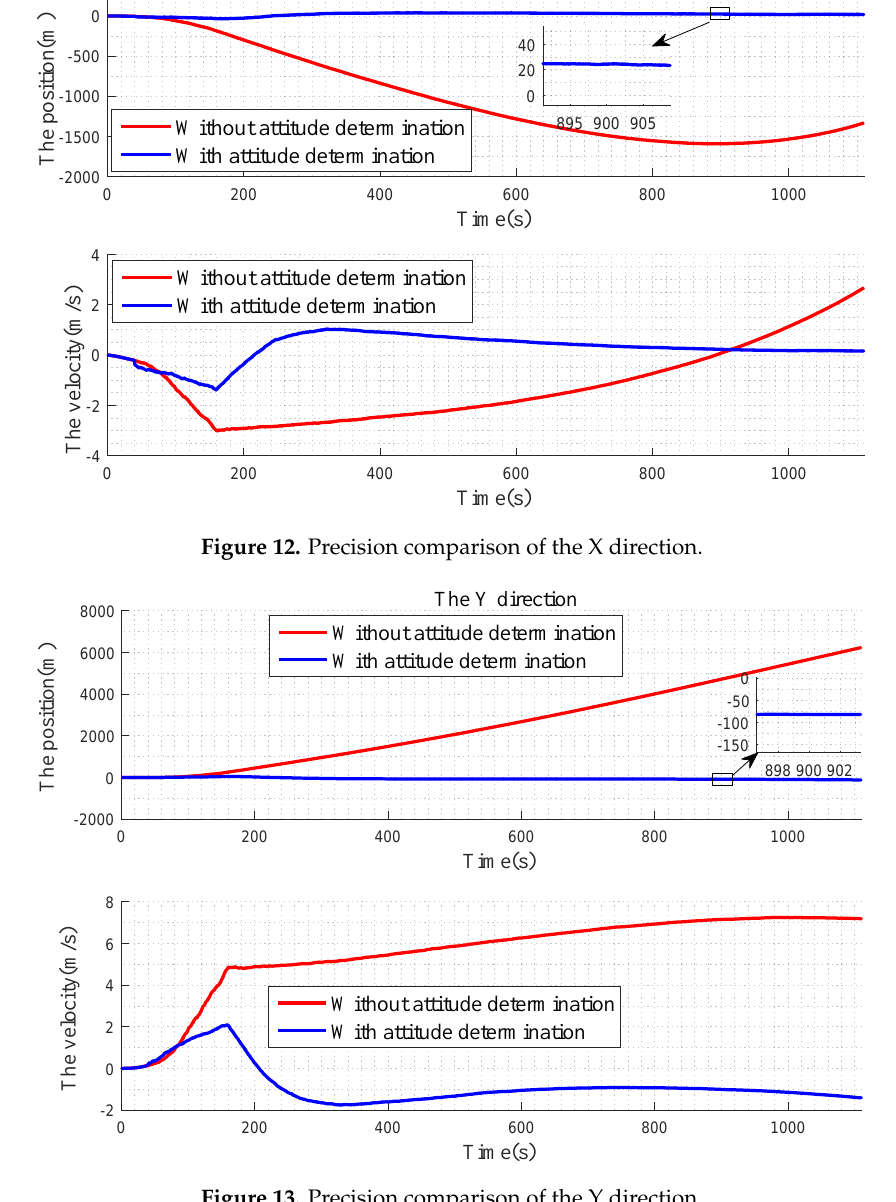
Figure 13. Precision comparison of the Y